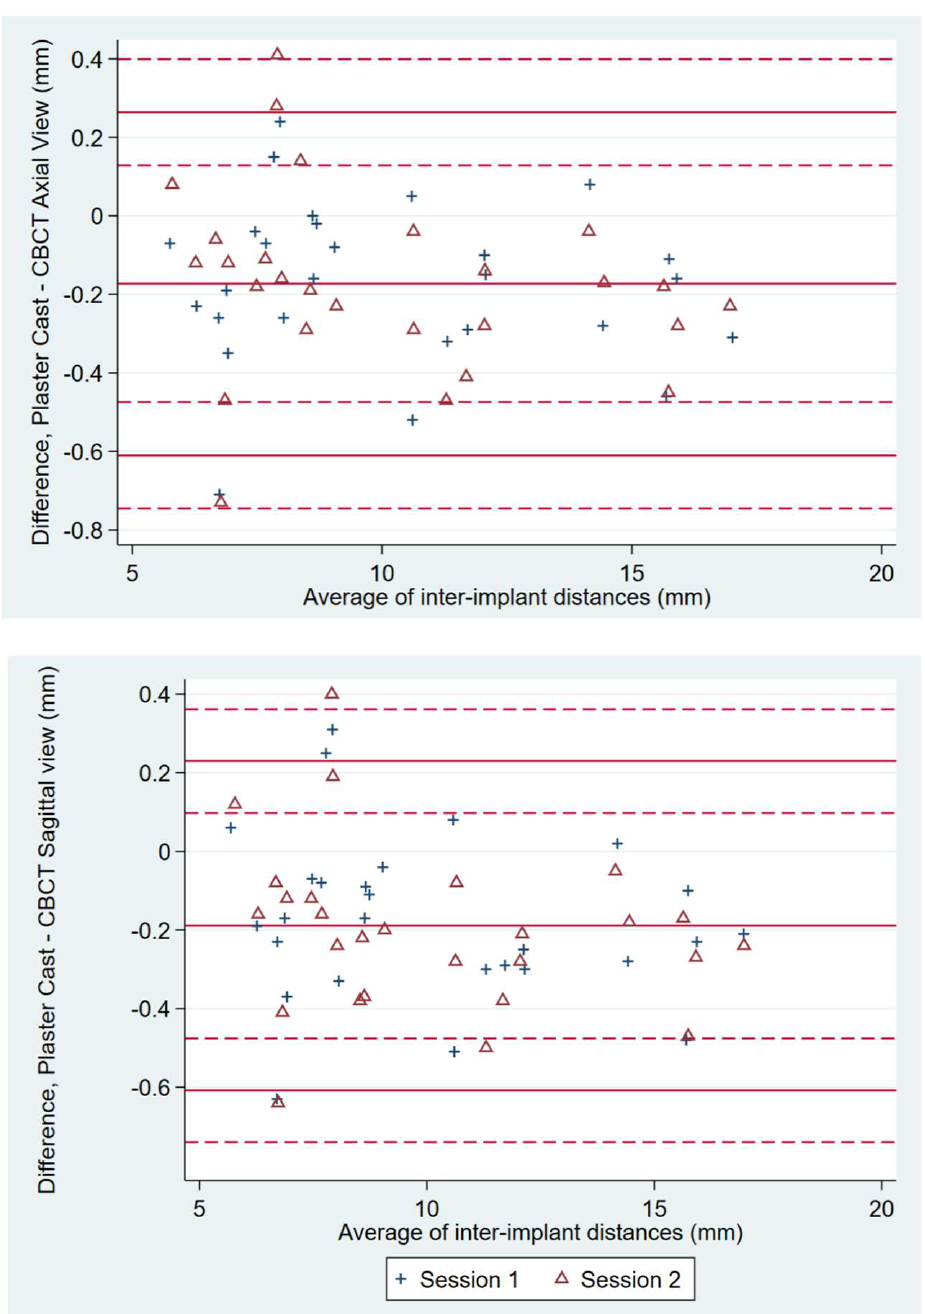
Figure 4. For observer 2, the effect of each method (plaster cast vs. CBCT axial view and plaster cast vs. CBCT sagittal view) on the average measurement was examined using a linear regression mixed model. Methods and observers were considered fixed